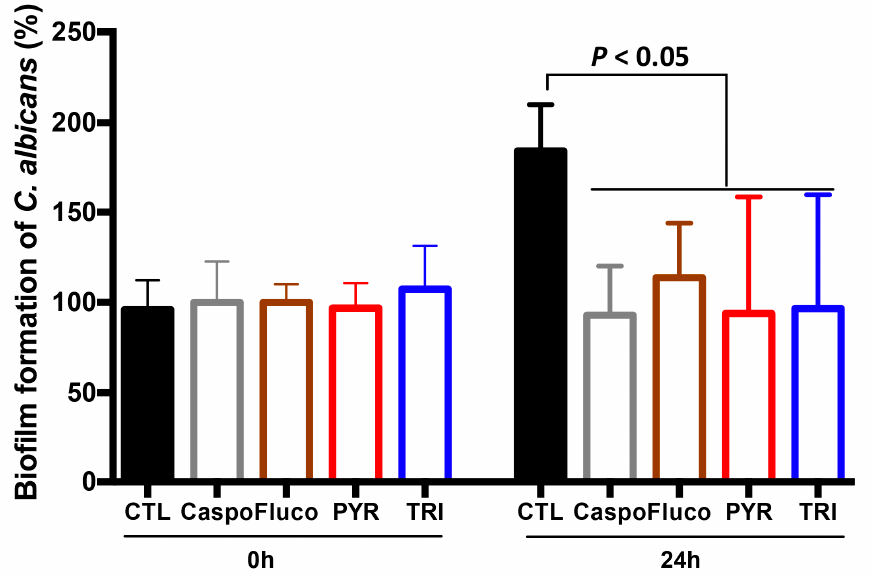
Figure 5. Effect of PYR and TRI on C. albicans biofilm formation. C. albicans SC5314 cells were allowed to form a biofilm for 24 h. C. albicans biofilms were treated with caspofungin (Caspo), fluconazole (Fluco), PYR, or TRI at their 1 × MIC for 24 h. CTL represents C. albicans alone without any antifungal treatment. Error bars indicate standard deviations.